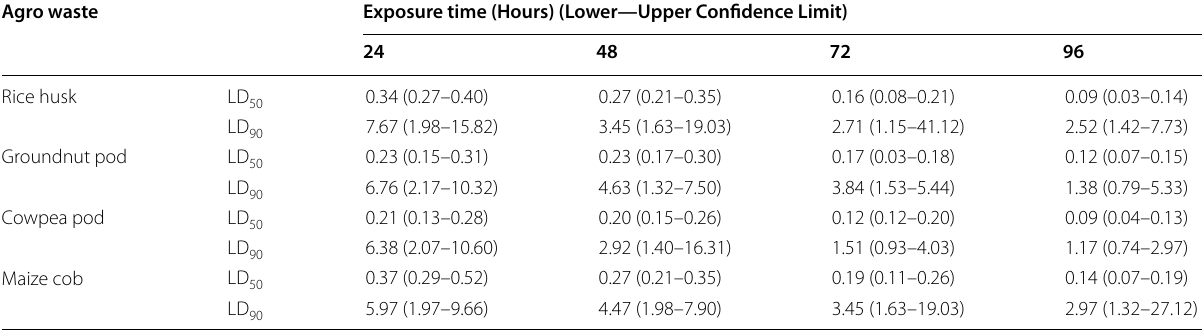
and LD ) of agro-waste powders against C. 50 90